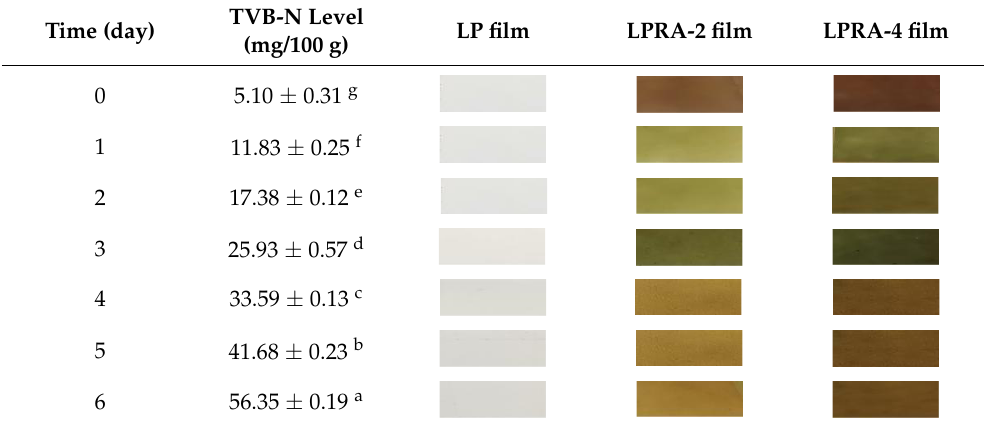
Table 2. The change of TVB-N levels in the shrimp and the color changes of LP film, LPRA-2 film, and LPRA-4 film.